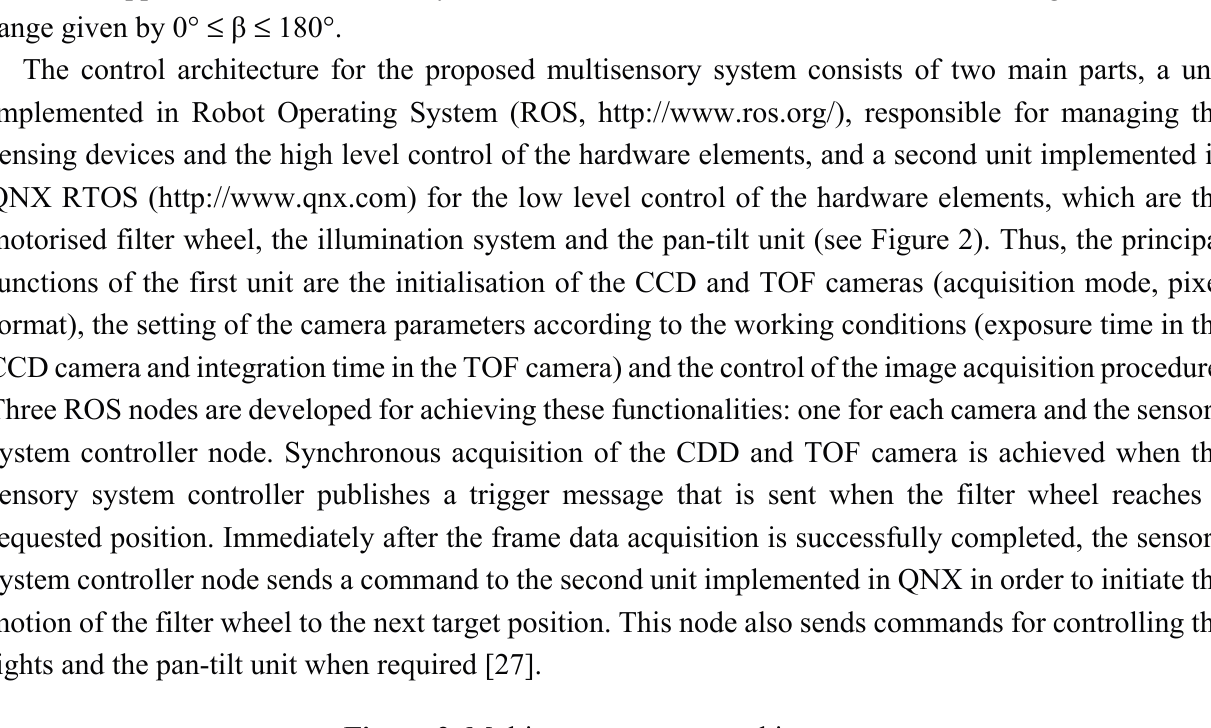
Figure 2. Multisensory system